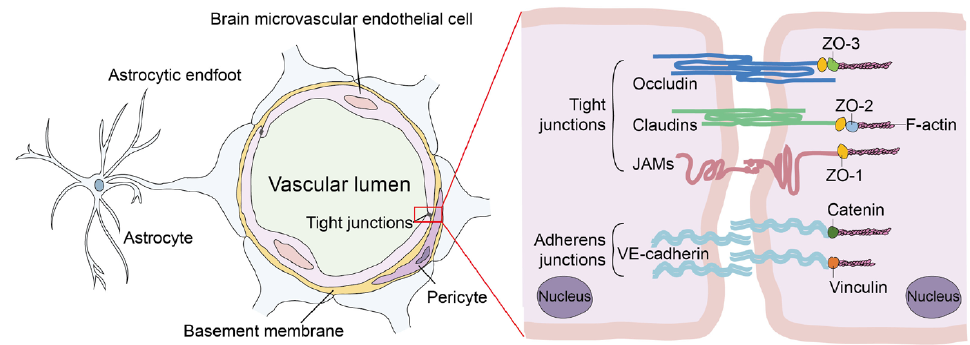
Figure 1. Schematic architecture of cellular components and molecules involved in the regulation of BBB BBB integrity.